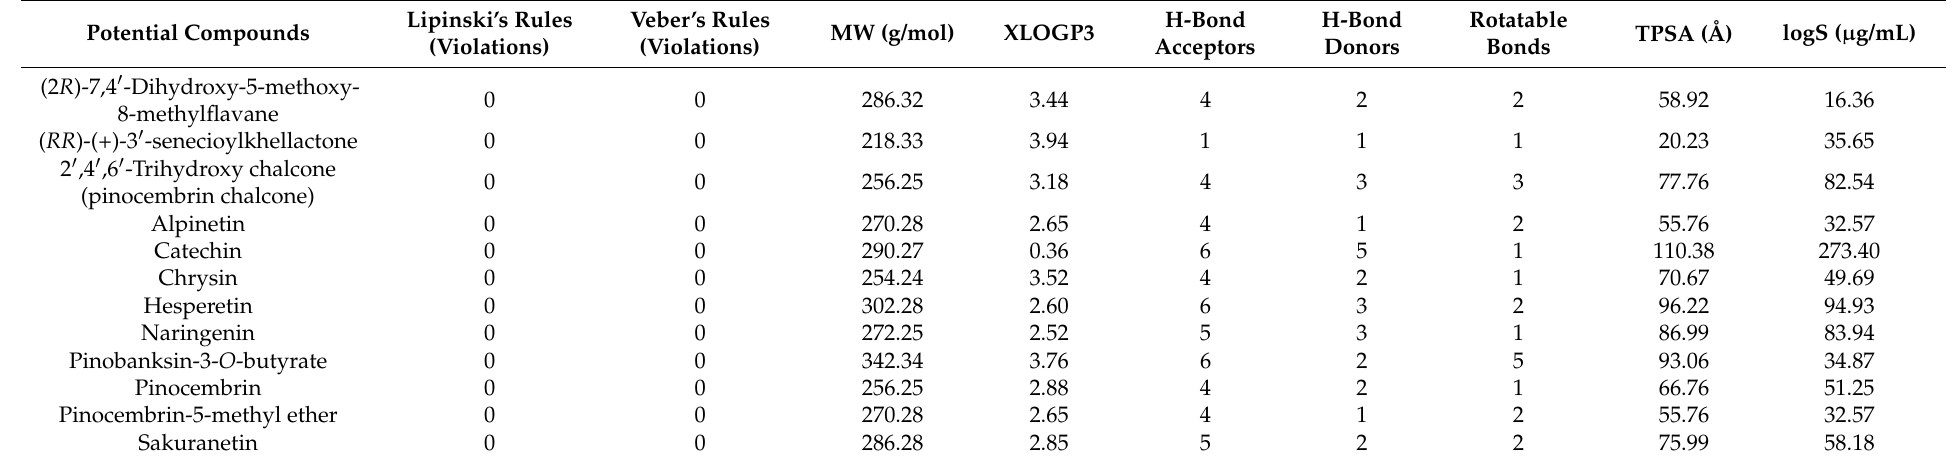
Table 4. Predicted physicochemical properties of potential compounds from Asian propolis.